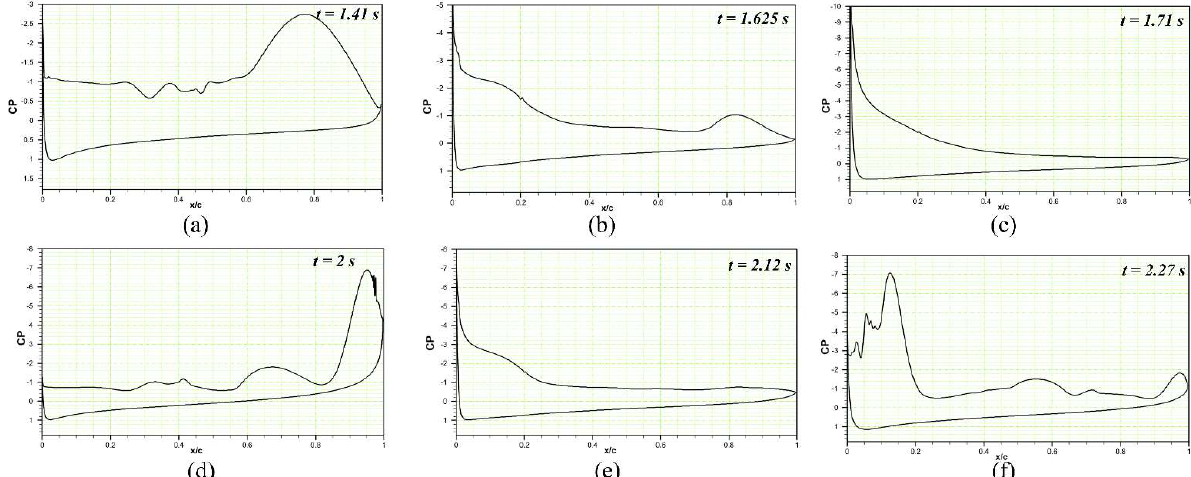
Figure 19. Pressure coefficient variations along the chord comparison of the reference airfoil with the DMLE airfoil at the angle of attack of 22° at the deflection frequency of 2 Hz for ( a ) time step of 1.41 s, ( b ) time step of 1.625 s, ( c ) time step of 1.71 s, ( d ) time step of 2 s, ( e ) 2.12 s and ( f ) time step of 2.27 s. These figures reveal the pressure coefficients at different morphing leading edge deflections and how the flow stability increases by minimizing the flow separation over an airfoil. At the deflection frequency of 5 Hz, the DMLE droops at a faster rate compared to its behavior at low frequencies such as 0.01 Hz and 0.005 Hz. Figure 20a shows the chordwise pressure distribution at t = 1.41 s; LEVs can be observed over the airfoil. At t = 1.55 s, the leading-edge droops to the maximum value, and a large TEV can be seen over the airfoil (Figure 20b). When the leading edge starts to return to its original position, the flow sta- bilizes and reattaches with the airfoil, as seen at t = 1.6 s (Figure 20c). The flow takes more time to reattach to the airfoil at high frequencies as compared to low-frequency deflec- tions. The leading edge continues to deflect upwards, and the large LEV and flow separa- tion can be seen at t = 1.645 s (Figure 20d). Similar type outcomes are obtained for the deflection frequency of 10 Hz, as shown in Figure 21a–d.